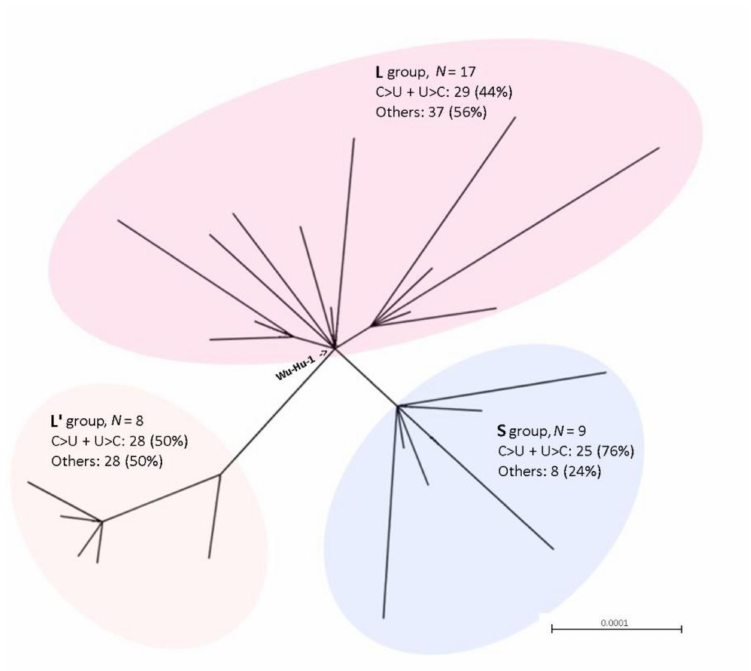
Figure 2. Phylogenetic relationships between human SARS-CoV-2 viruses. The maximum-likelihood tree was constructed from the alignment of 34 whole genome sequences (Table S1). Statistical support calculated as the approximate likelihood-ratio test [29] was 98% for three branches indicated in colors. The reference Wu-Hu-1 (M908947) sequence fell within the “L” group. N —number of sequences in each branch followed by the frequency of substitution